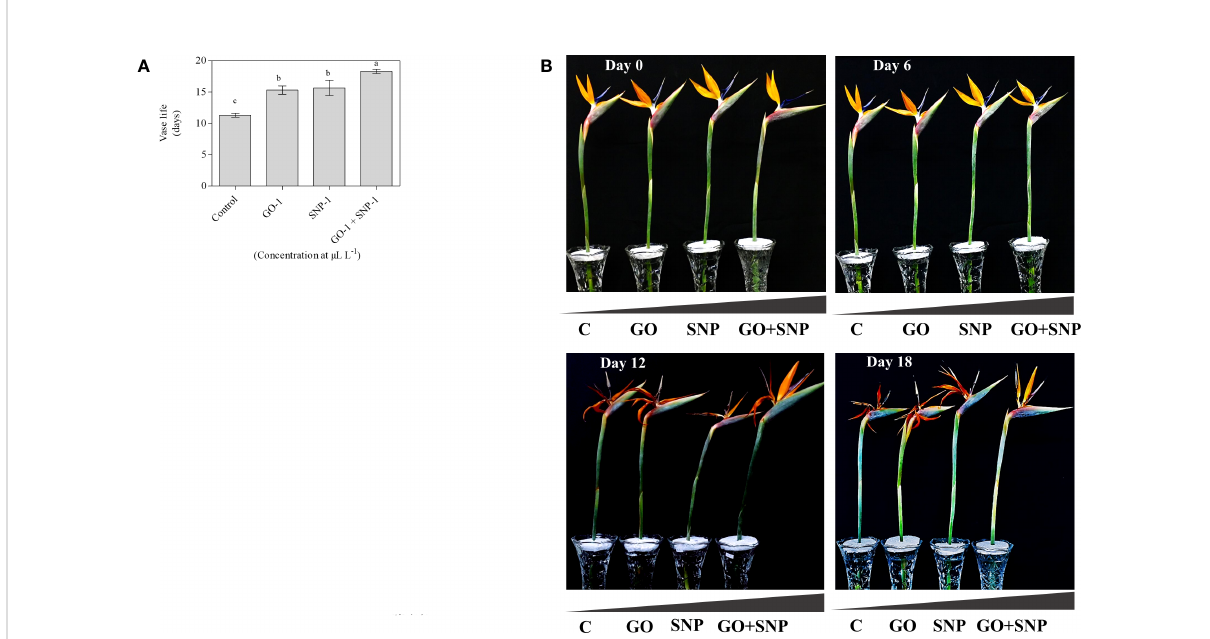
FIGURE 2 Effect of NPs (C, GO, SNP and GO + SNP at 1 µL L − 1 on (A) vase life and (B) vase performance on cut spikes of bird of paradise. Means with different letters are signi fi cantly different from each other (Duncan ’ s multiple range test, p =